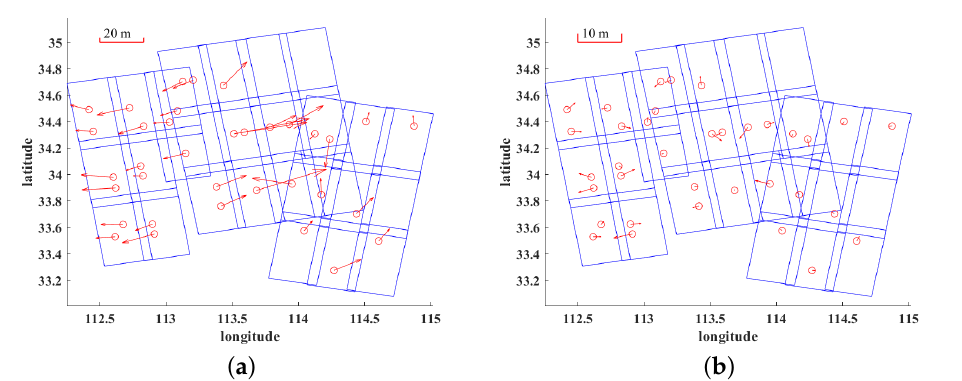
Figure 13. Error vector diagrams of checkpoints ( a ) before and ( b ) after adjustment by the proposed method. The circles and arrows are the positions and errors of